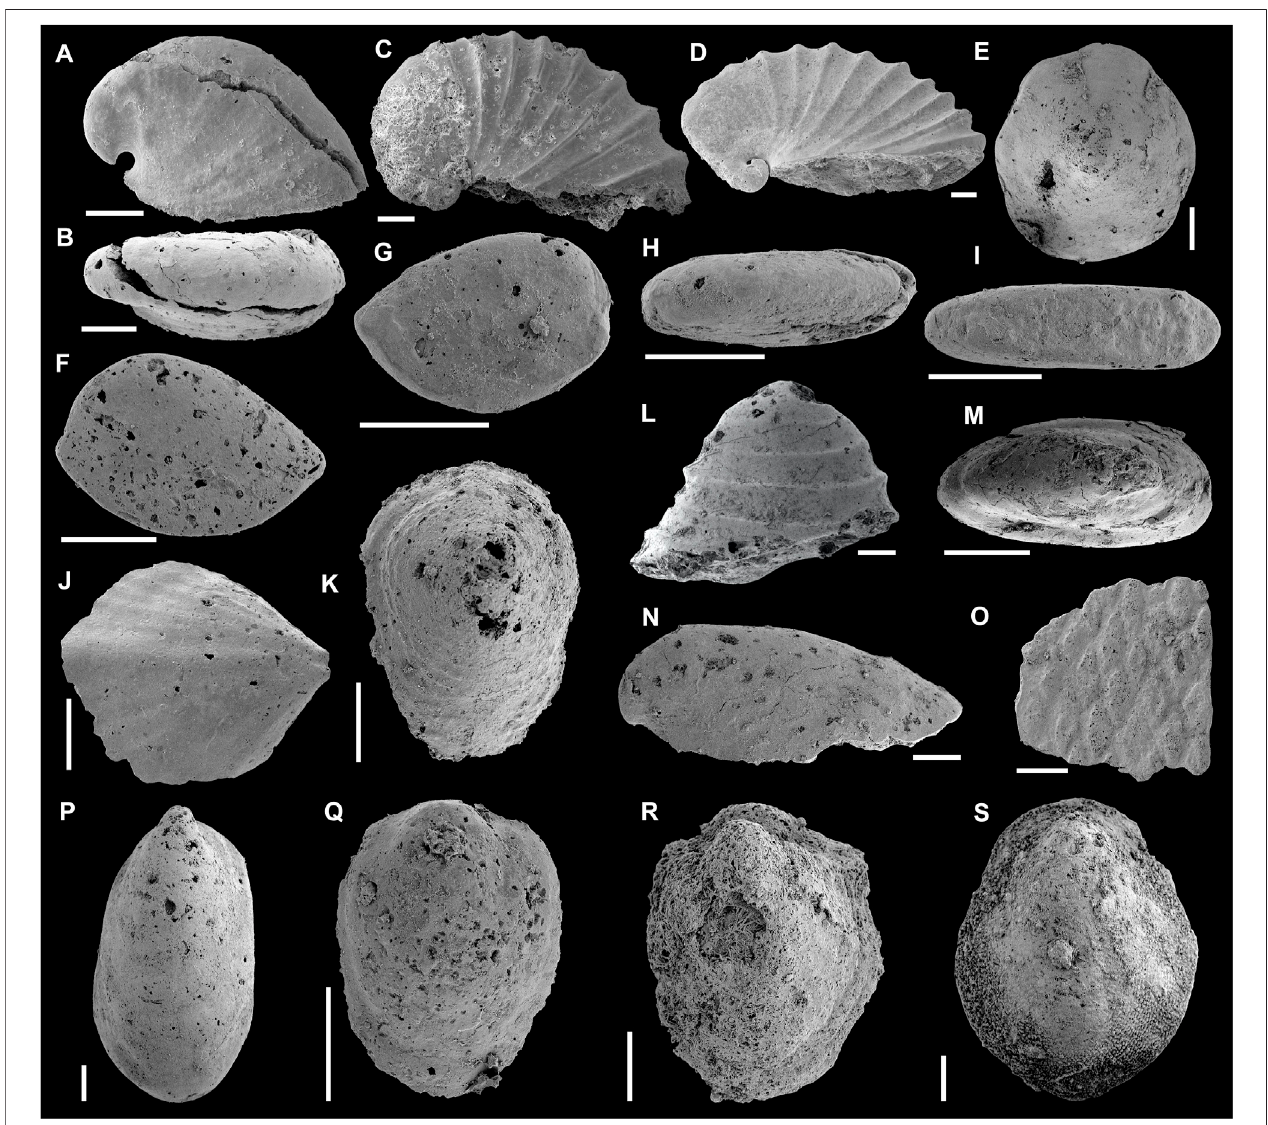
FIGURE4| Smallshelly fossilsfrom theupper Maidiping Formation at theFandiansection. (A,B) Igorellamaidipingensis (Yu,1974),NIGPAS 180279,LSF-12.1m; (A) lateral view; (B) dorsal view. (C,D) Oelandiella korobkovi Vostokova, 1962; (C) NIGPAS 180280, LSF-12.1m, lateral view; (D) NIGPAS 180281, LSF-13m, lateral- apertural view. (E) Aegitellus emeishanensis (He in Yin et al., 1980), NIGPAS 180282, LSF-13.5m, apical view. (F – I) Watsonella crosbyi Grabau, 1900; (E) NIGPAS 180283,LSF-18m,lateralview; (F) NIGPAS180284,LSF-18m,lateralview; (G) NIGPAS180285,LSF-18m,dorsalview; (H)